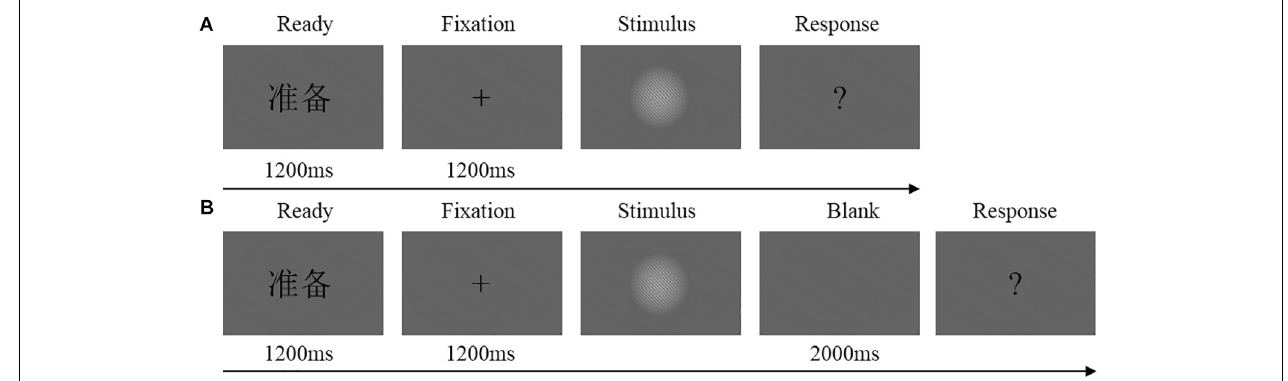
FIGURE 1 | (A) Flowchart of experimental trial procedure in the immediate detection task. Each trial started with the presentation of a Chinese word “ ”(i.e., “READY”) at the center of the screen for 1200 ms, flowed by the fixation cross for 1200 ms and the stimulus for an individually calibrated duration (or blank screen in catch trials). After the stimulus (or blank), a question mark was presented until the participants make their decision whether they had seen the stimulus or not. (B) Flowchart of experimental trial procedure in the delayed detection task. Each trial started with the presentation of a Chinese word “ ” at the center of the screen for 1200 ms, flowed by the fixation cross for 1200 ms and the stimulus for an individually calibrated duration (or blank screen in catch trials). Then, the screen was blank for 2000 ms. After the blank, a question mark was presented until the participants make their decision whether they had seen the stimulus or not.